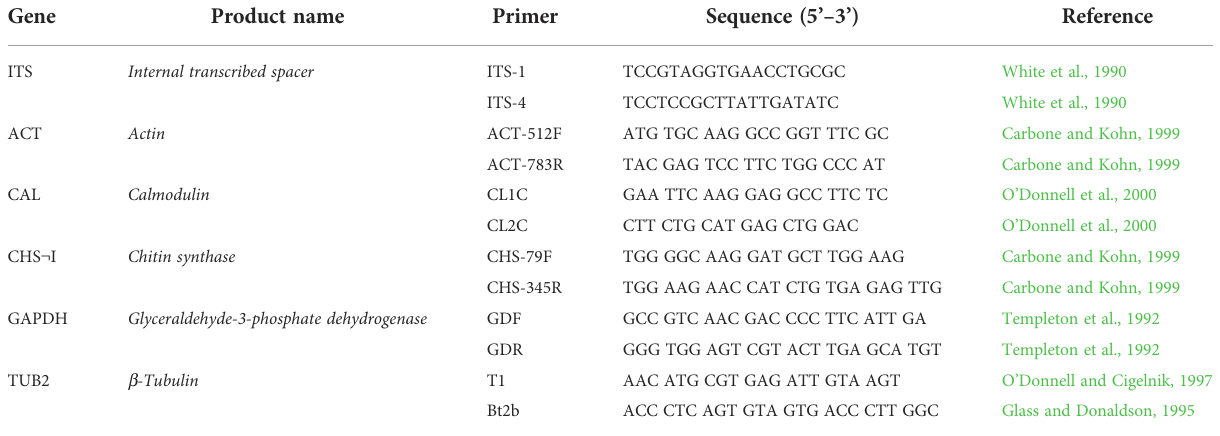
TABLE 2 Primers used in this